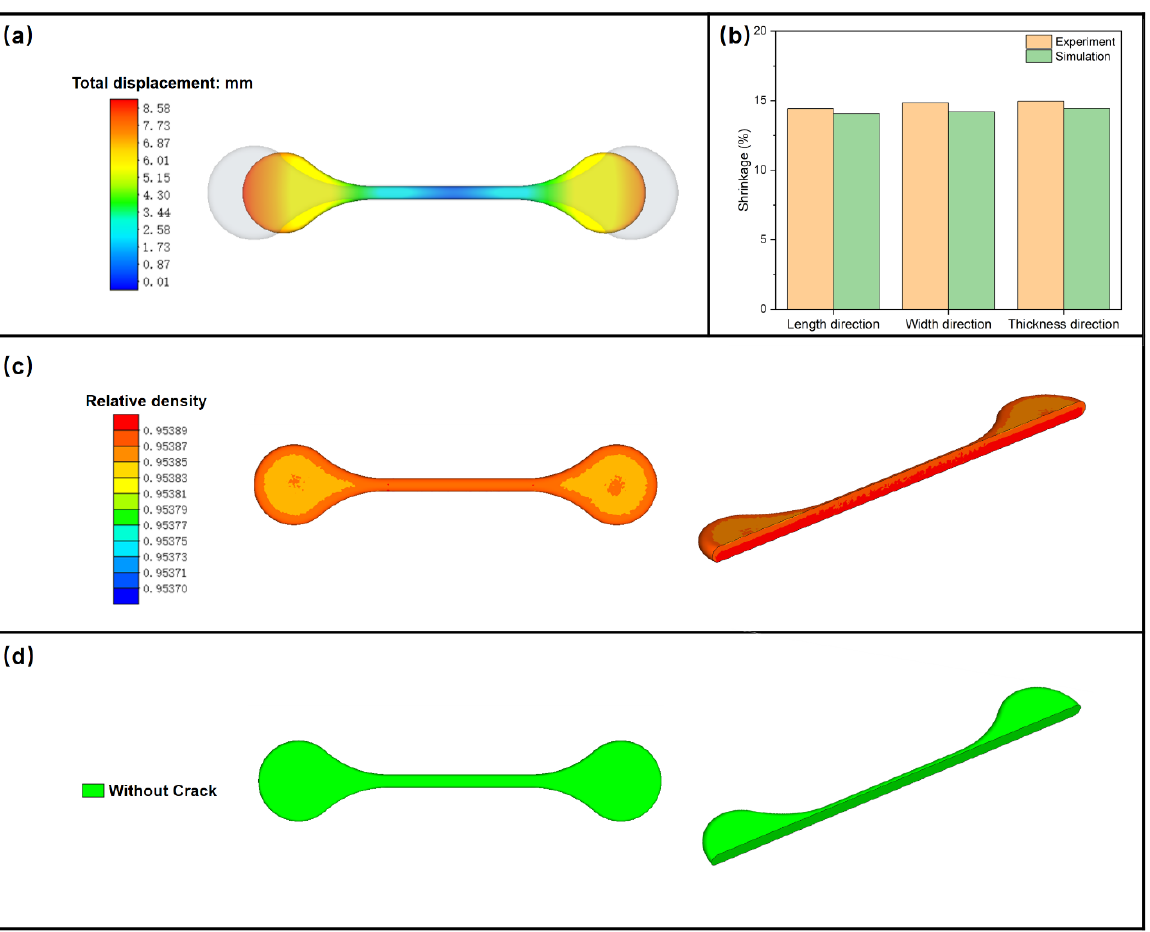
Figure 6. Properties of the elongated specimen for laid Ti-6Al-4V. ( a ) Total shrinkage, ( b ) shrinkage along different directions, ( c ) relative density, and ( d ) crack.